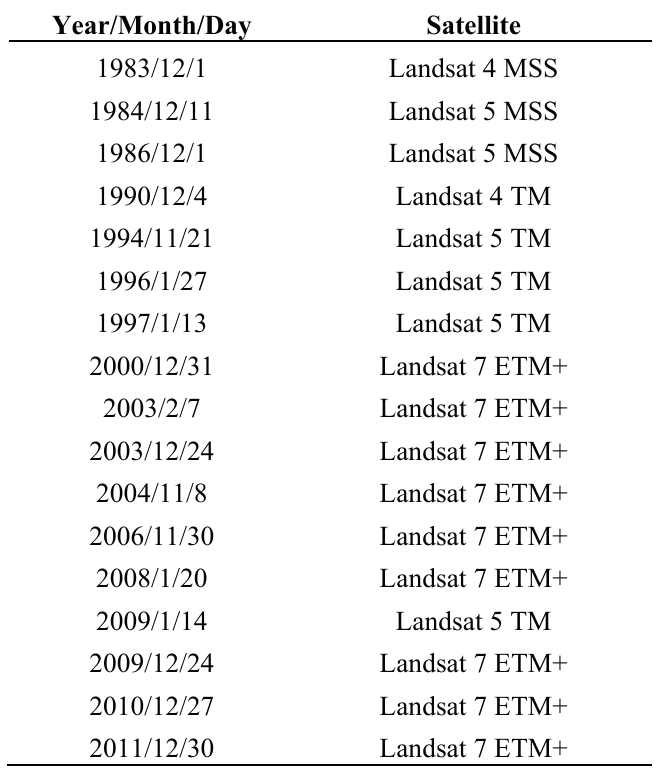
Table 1. Landsat imagery used in this